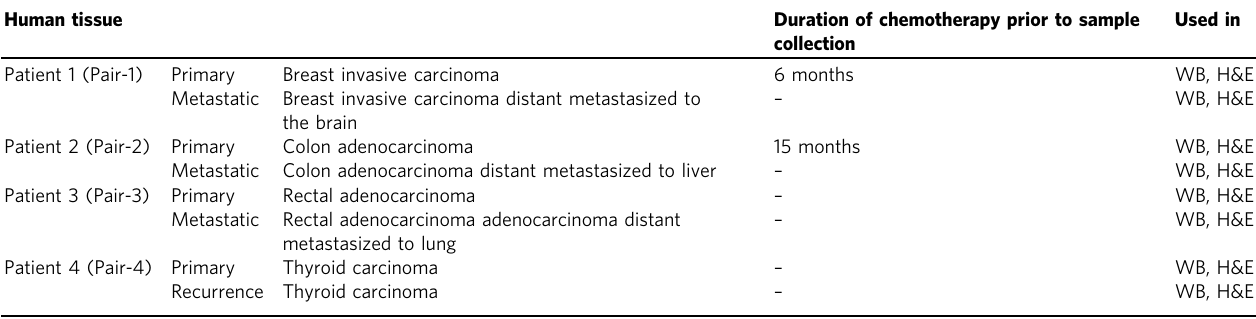
Table 1 Clinicopathological details of fresh-frozen human samples analyzed in this study. Human tissue Duration of chemotherapy prior to sample